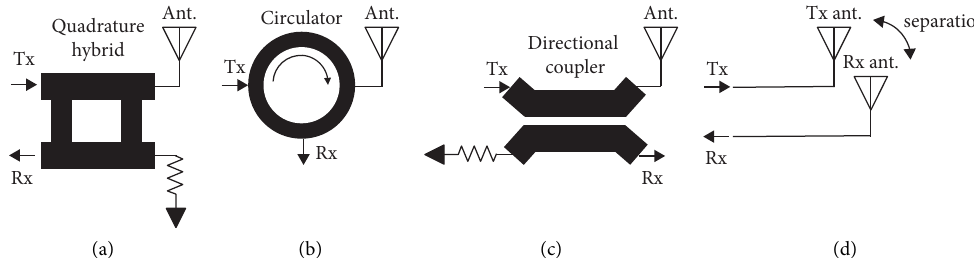
Figure 1: Conventional methods to isolate Tx and Rx using (a) a quadrature hybrid, (b) a circulator, (c) a directional coupler in monostatic system, and (d) antenna space separation.